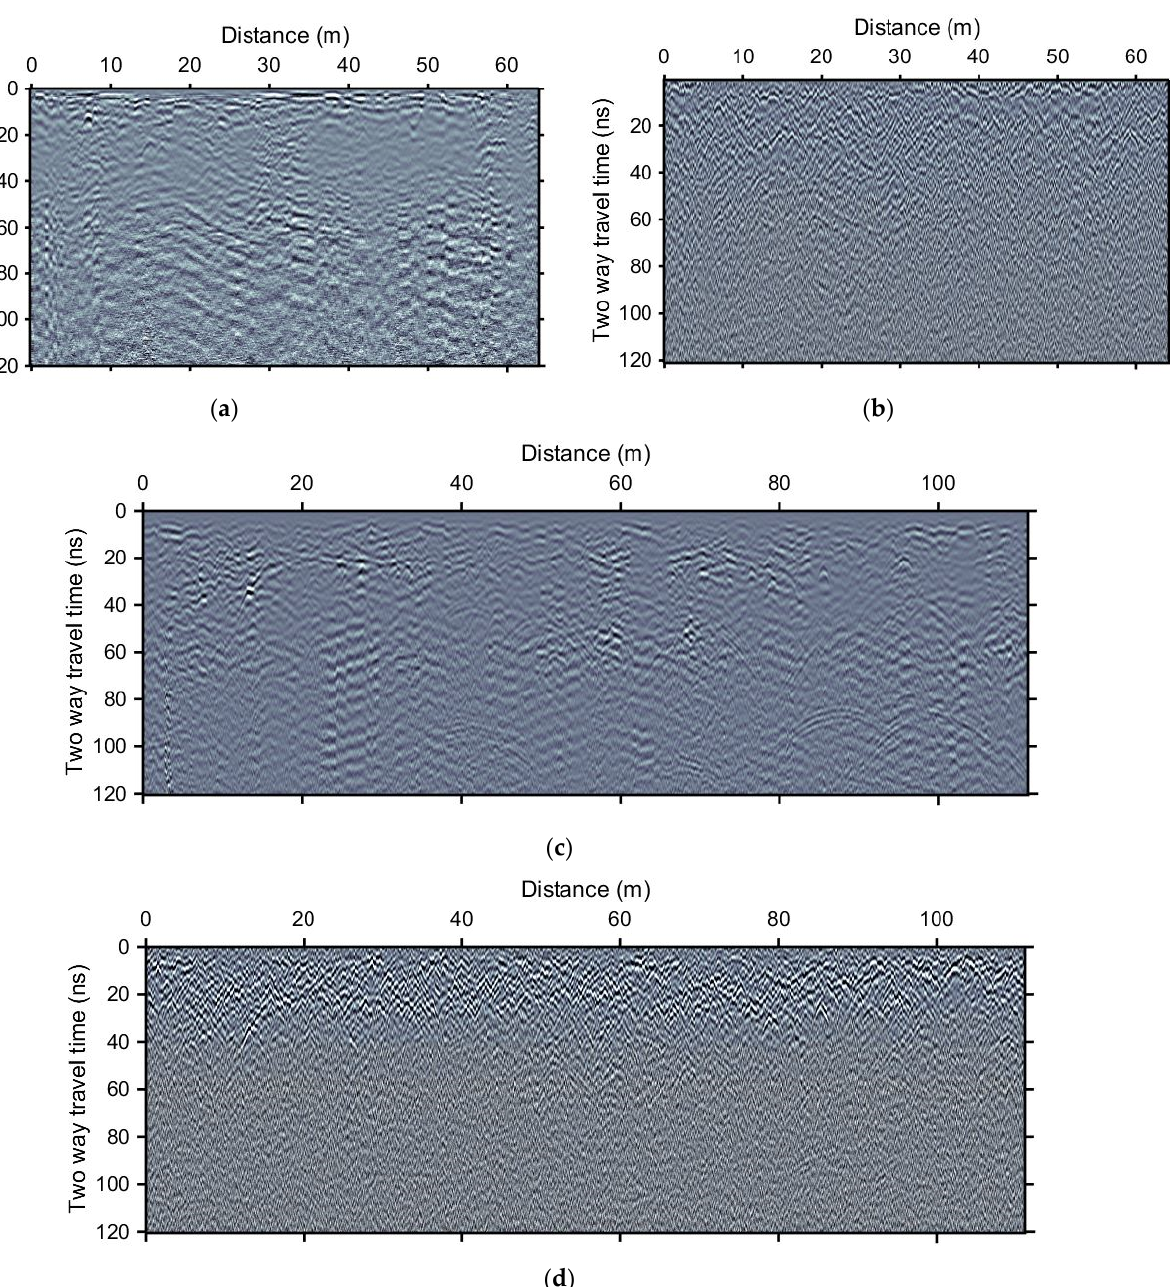
Figure 7. GPR processed sections. ( a ) Northwestern GPR section (red line at almost in the middle of the ERT profile, Figure 3), after conventional processing, ( b ) is ( a ) after plane wave destruction filtering, ( c ) Southeastern GPR section (red line covering almost all the second half of the ERT profile, Figure 3), after conventional processing and ( d ) is ( c ) after plane wave destruction filtering. Details for conventional processing can be found in the paper text.